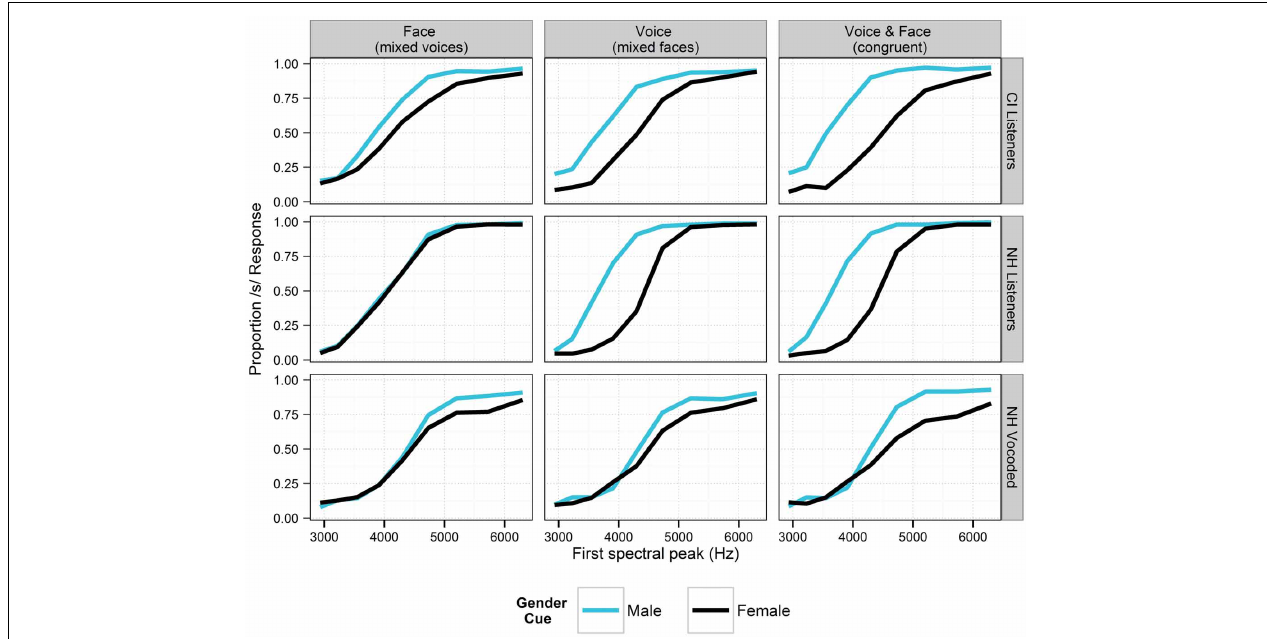
FIGURE 4 | Perception of the fricative continuum in the context of various auditory, visual and audio-visual cues to talker gender for listeners in Experiment 2. For each cue, responses are collapsed across all levels of the other cues (i.e., the data include all levels of vowel context and consonant lip rounding). The “Face” and “Voice” columns show data where